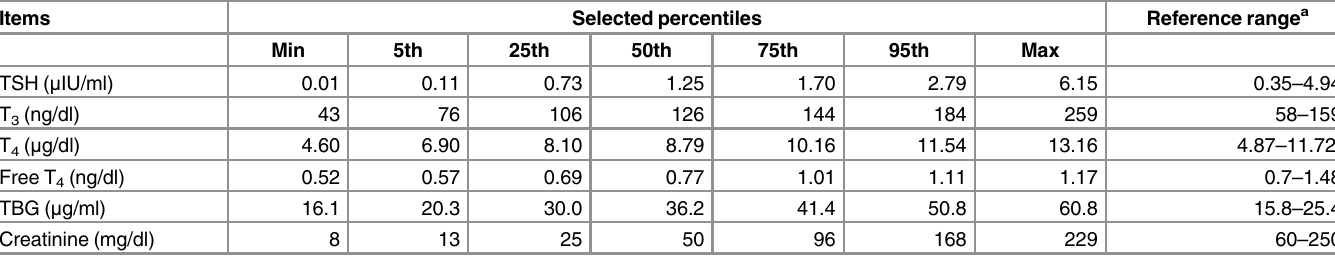
Table 3. Distribution of serum thyroid hormones and urinary creatinine in participants (N = 97) at the first trimester. Items Selected percentiles Reference range a Min 5th 25th TSH ( μ IU/ml)